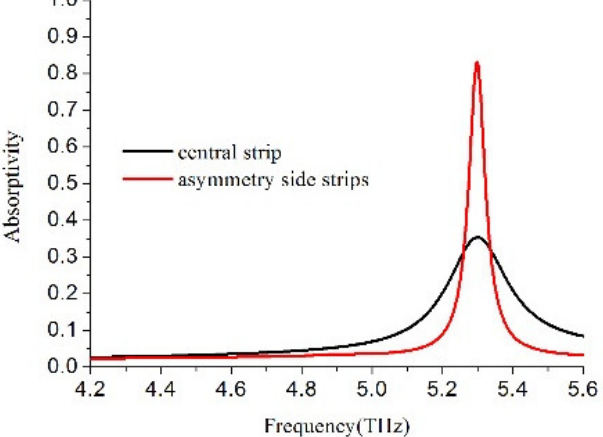
Figure 4. Individual absorption resonances of the central strip and asymmetrical side strips with the same resonance frequency, different Q factor, and different absorption strength.